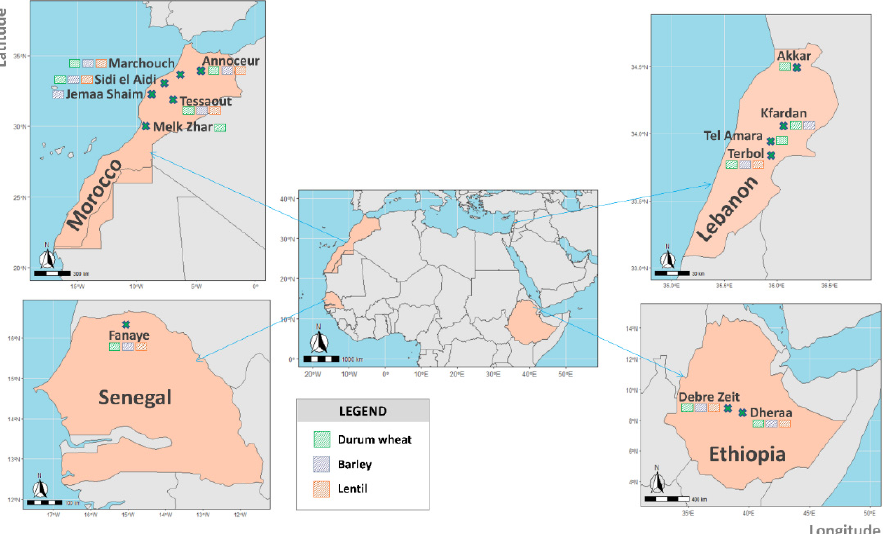
Figure 1. Geographical distribution of experimental farms used in this study. Square symbols are used to indicate the tested crop at each site.